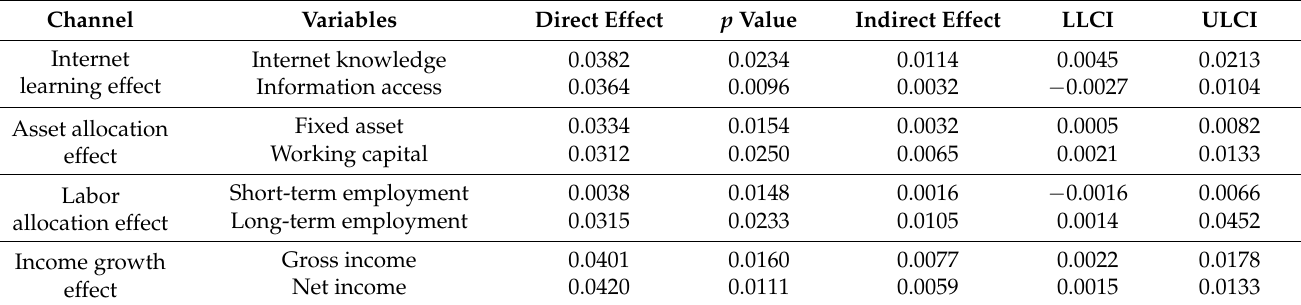
Table 7. The mechanism of how formal credit affects e-commerce